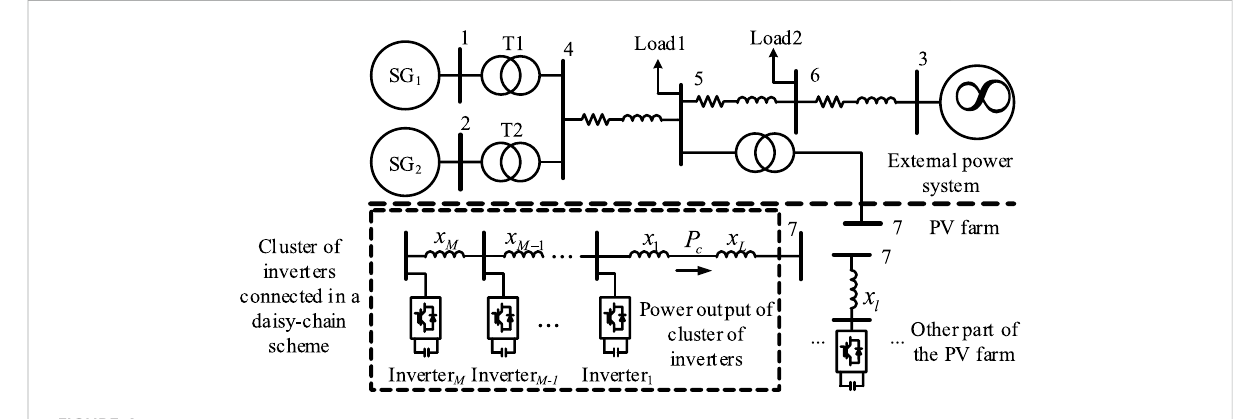
FIGURE 4 An example power system with a grid-connected PV power generation farm.